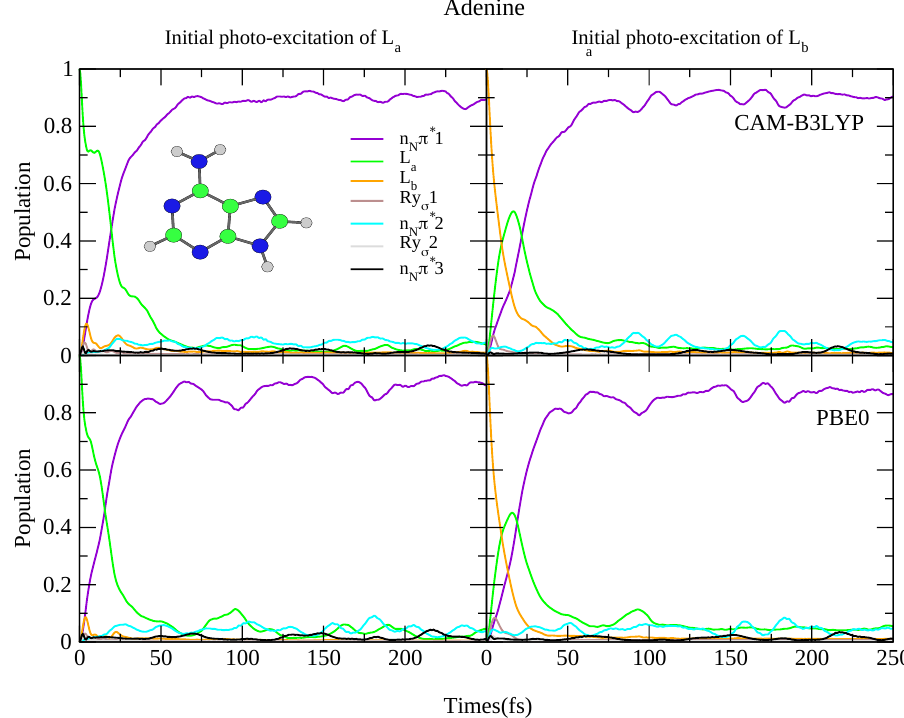
Figure 8. Nonadiabatic dynamics of electronic populations of Adenine in the gas phase, as predicted by an LVC Hamiltonian parameterised with calculations at C s minimum using CAM-B3LYP ( top ) and PBE0 ( bottom ) functionals with 6-311+G(d,p) basis